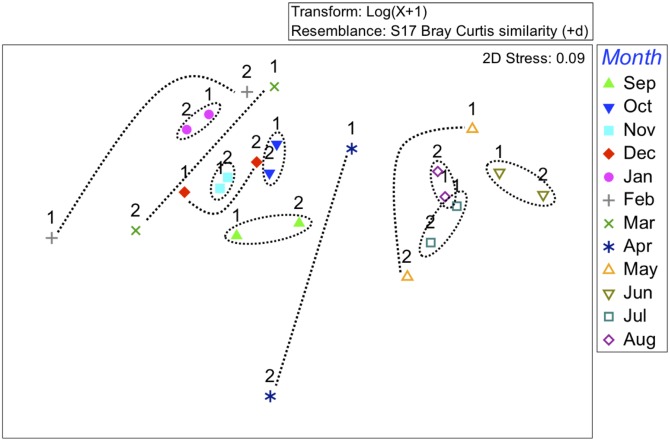
Nonmetric Multidimensional Scaling ordination (NMDS) plotted from average abundances of fish eggs for each species per month.Based on Bray-Curtis dissimilarities from log-transformed (x+1) data. The stress value indicates that the plot gives an adequate representation of the data. Numbers “1” or “2” above each point represent the first or second sampling year. Dotted lines connect or encircle the same months.